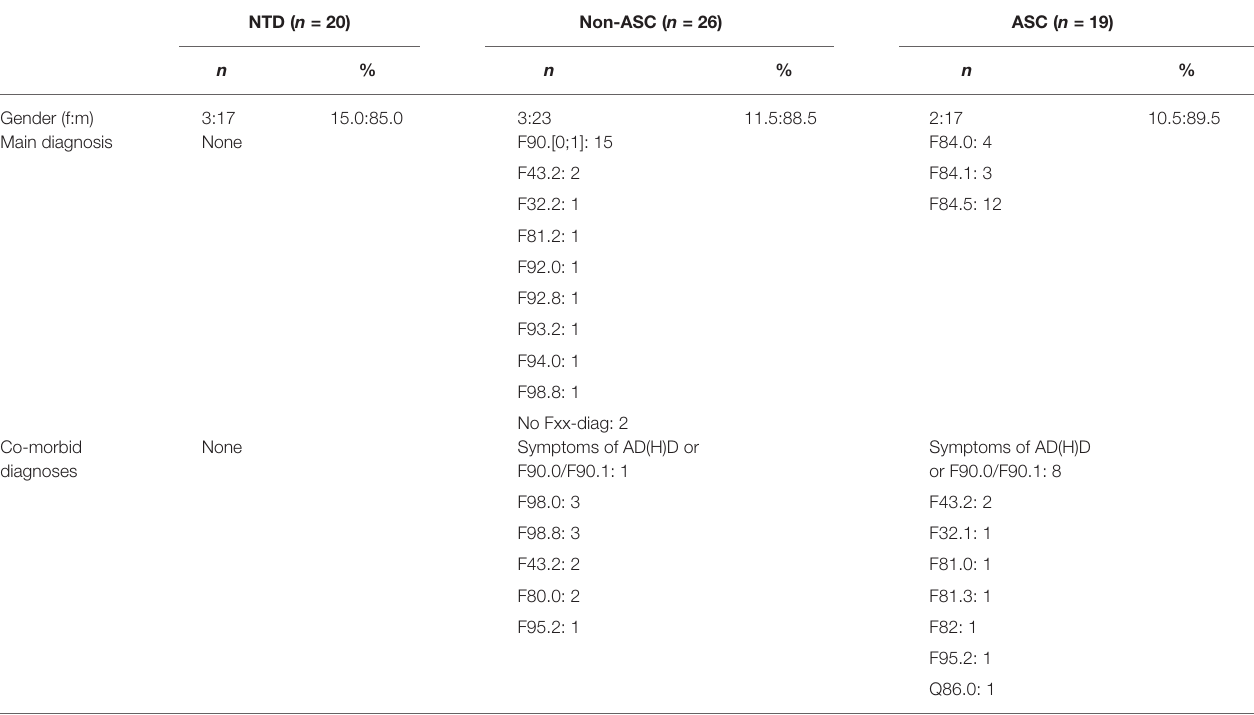
TABLE 2 | Sample characteristics for the qualitative variables gender, main diagnoses, and co-morbid